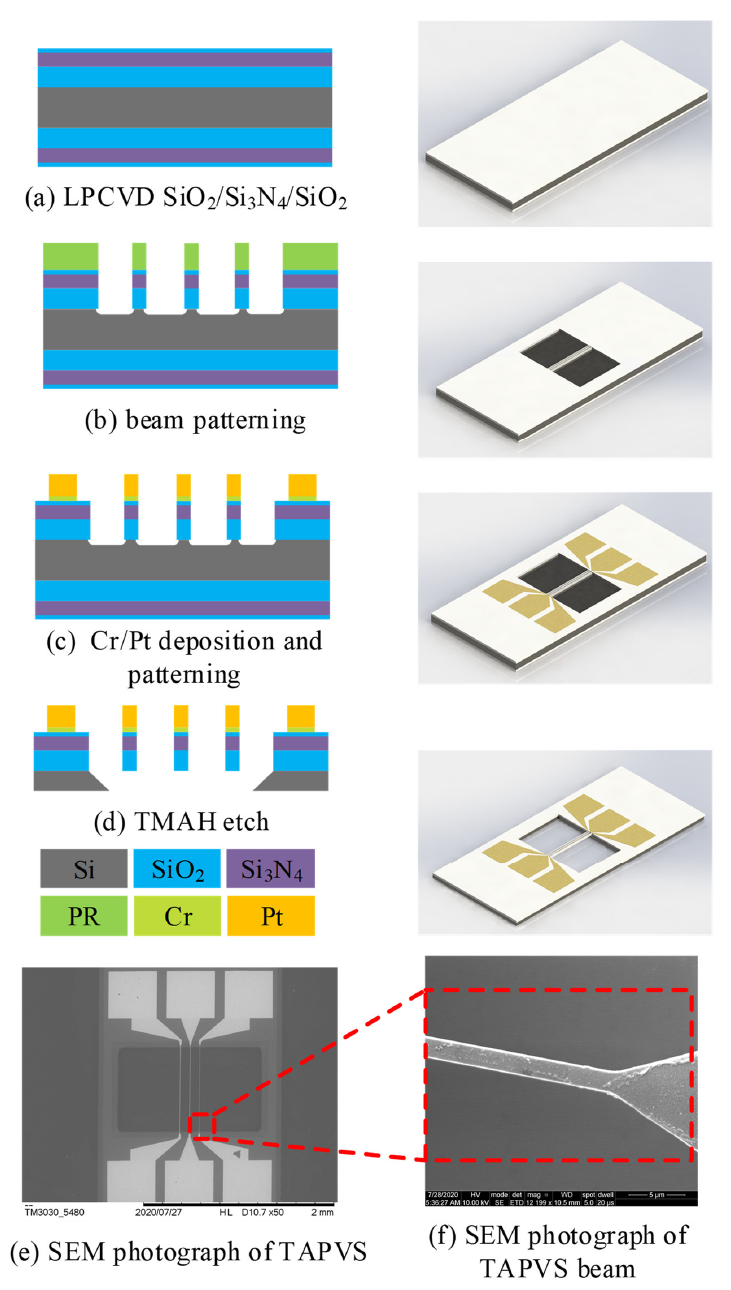
Figure 9. Key steps of the fabrication process of TAPVS: ( a ) deposition of SiO 2 /Si 3 N 4 /SiO 2 ; ( b ) patterning the supporting layer of the beams and RIE, the exposed SiO 2 /Si 3 N 4 /SiO 2 , after the first photolithography; ( c ) deposition and lift-off of Cr/Pt; ( d ) releasing beams by TMAH anisotropic etching; ( e ) SEM photo of TAPVS; and ( f ) part of the thermistor beam. For comparison, both the DCT horn and the DC horn were fabricated with the